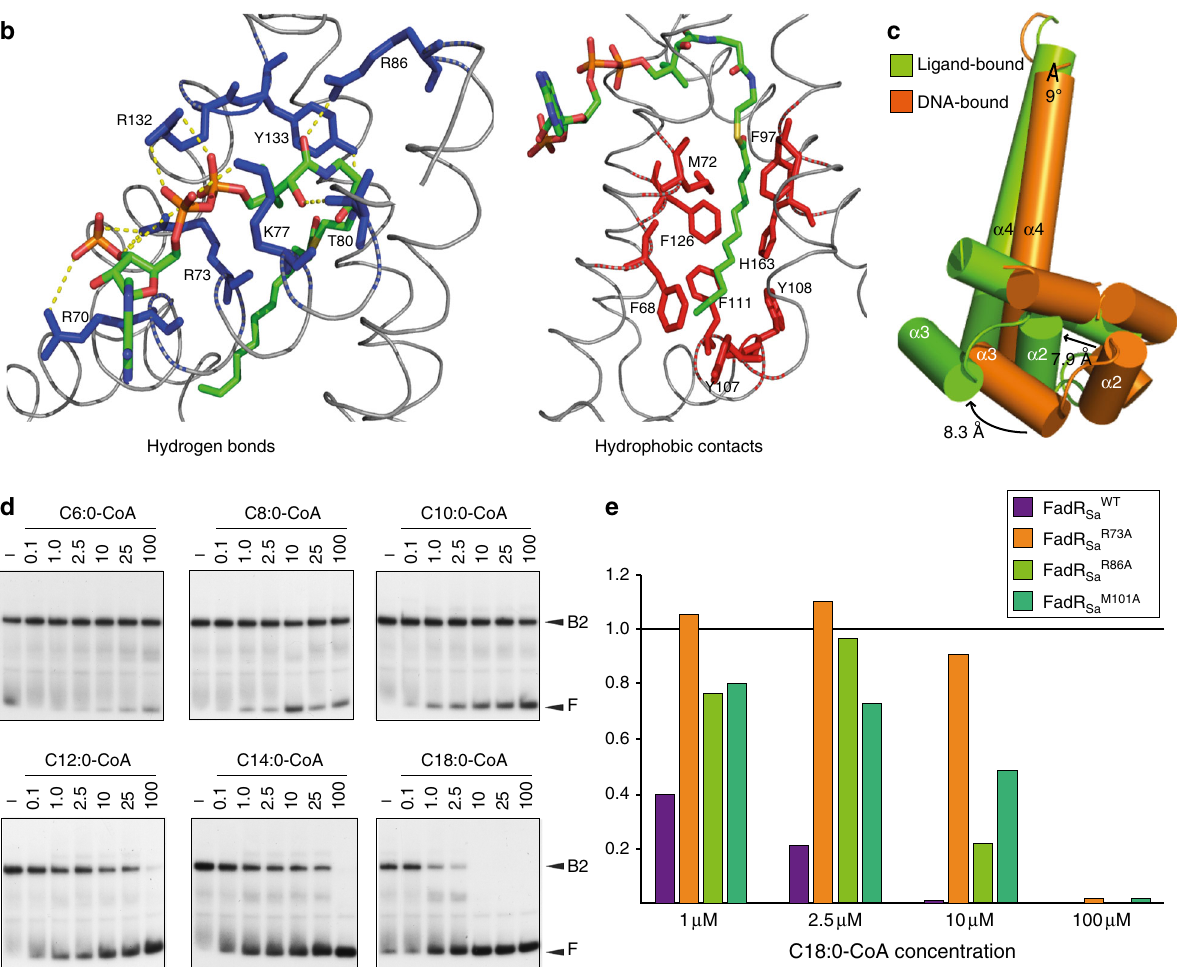
Fig. 7 Acyl-CoA disrupts FadR Sa – DNA complexes proportional to acyl chain length. a Structural comparison of ligand-binding modes of lauroyl – CoA-bound FadR Sa (PDB: 6EL2), lauroyl – CoA-bound FadR Tt (PDB: 3ANG) 24 , and lauroyl – CoA-bound FadR Bs (PDB: 3WHB) 25 . Only the C-terminal domains are shown in cartoon representation, with α -helices α 4 – α 9 colored from light to dark gray; the lauroyl – CoA molecule is shown as a stick model. Two different viewpoints are shown: a view from within the monomer-monomer interface in the dimer and a view perpendicular to that. b Close-up view of the ligand- binding pocket with indication of FadR Sa residues involved in establishing polar contacts with lauroyl – CoA (in blue) and of residues involved in hydrophobic interactions (in red). c Schematic representation of a close-up view of helices α 1 – α 4 with indication of relative conformational differences. A detailed structural superimposition is shown in Supplementary Figure 15b. d Electrophoretic mobility shift assays (EMSAs) demonstrating the effect of acyl-CoA on the FadR Sa – DNA interaction using a 154-bp probe representing the Saci_1106 binding site. Acyl-CoA concentrations are shown above each